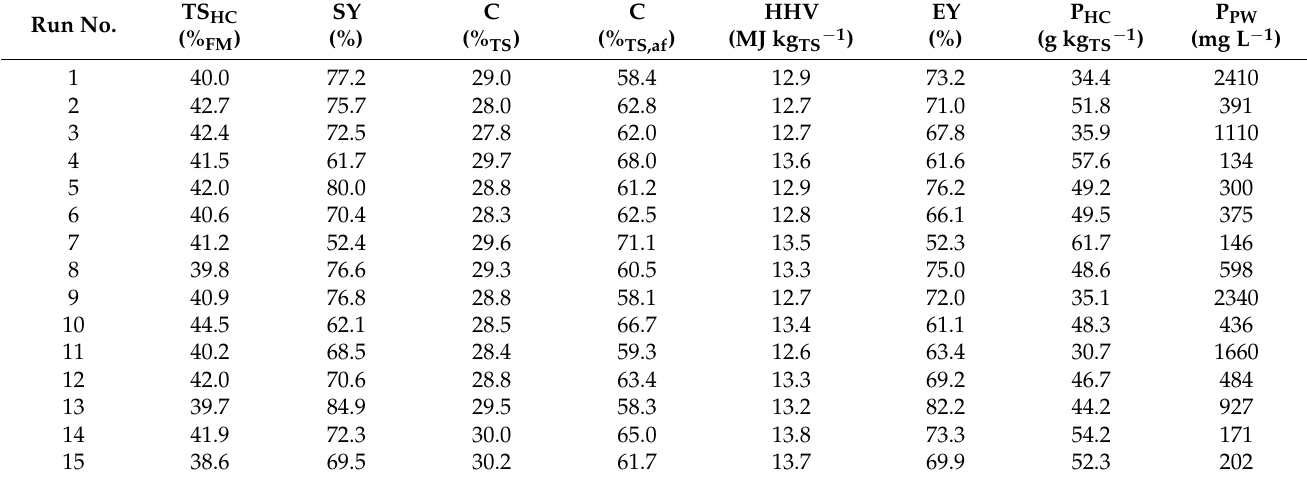
Table 2. Overview of the experimental